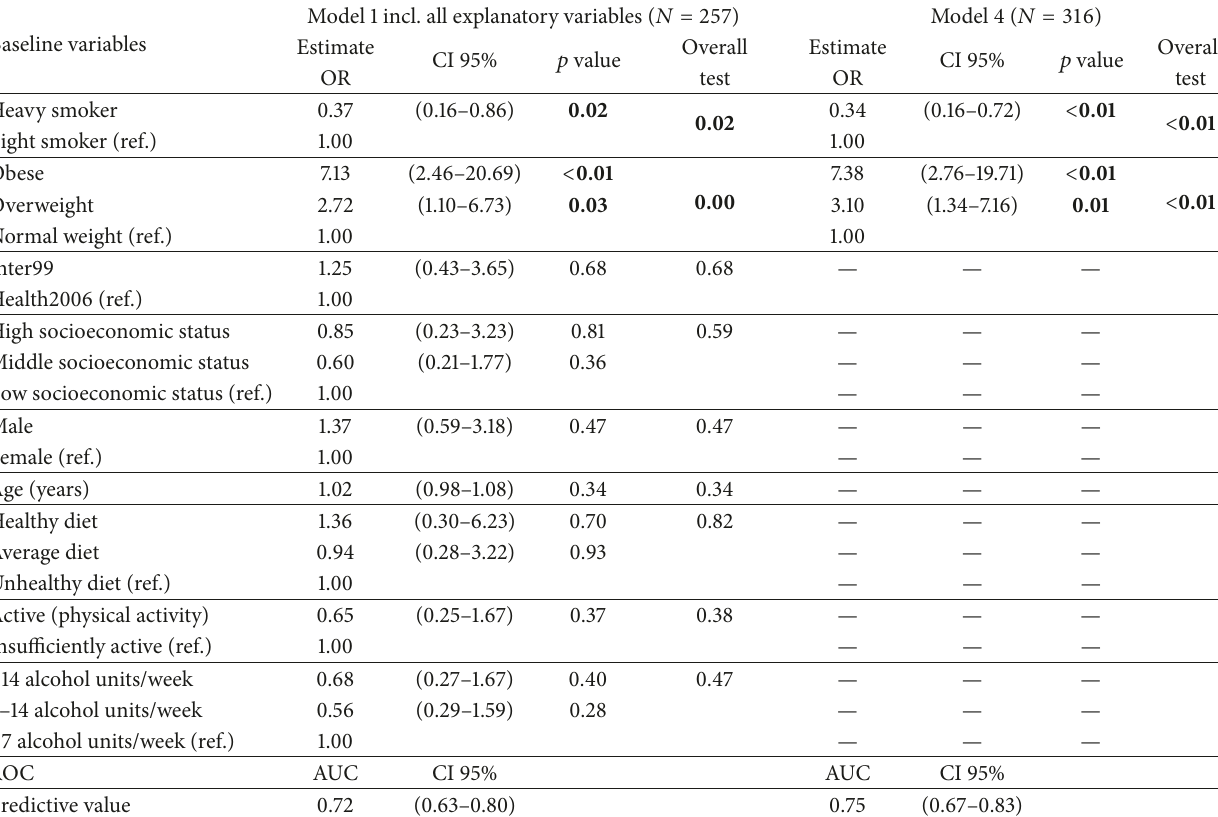
Table 3: Predictors of ex-smokers’ weight reduction after five years. Model 1 including all tested predictors. Model 4 including final